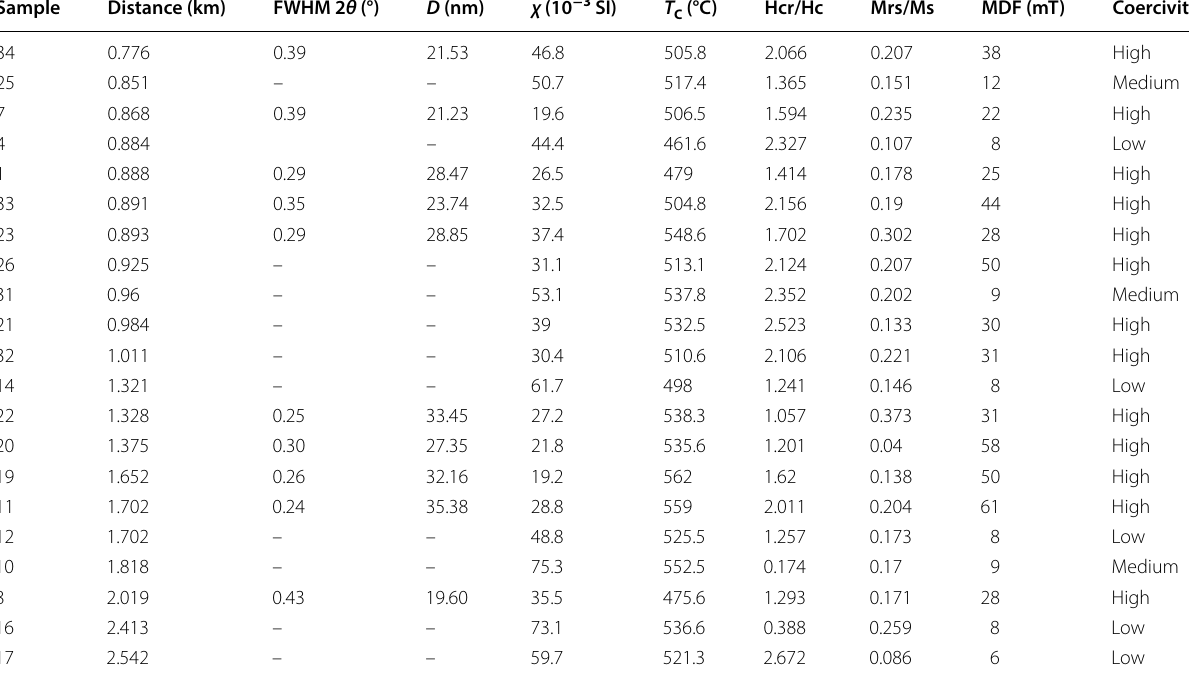
The median destructive field (MDF) and the coercivity estimates are taken from Agarwal et al. (2016)